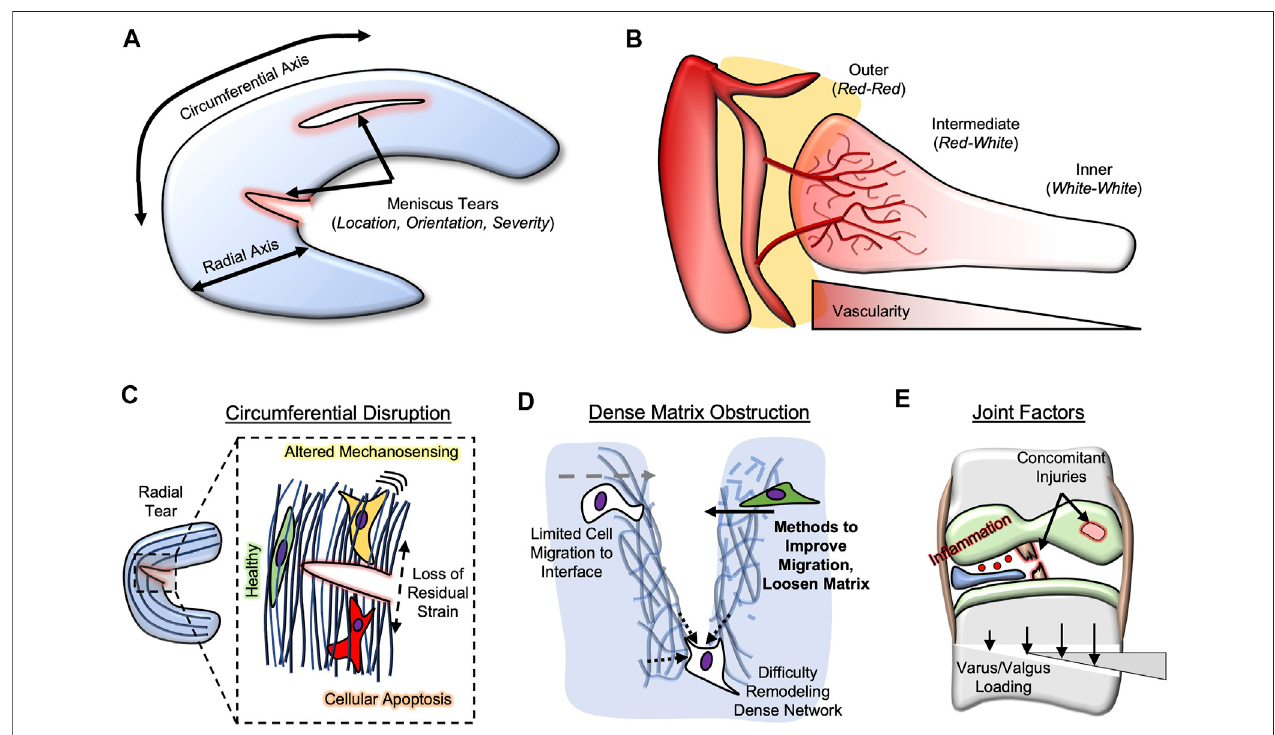
FIGURE 1 | Meniscus Repair Impediments. (A) Meniscus tears are often classi fi ed based on location, orientation, and severity. Location is usually classi fi ed by radial axis (inner, intermediate, outer) and circumferential axis (anterior, body, posterior). (B) Meniscus vascularity penetrates only partially into the meniscal body. (C) Circumferential network disruption (radial tears) lead to loss of residual strain, resulting in altered mechano-sensing and potentially cellular apoptosis. (D) Dense extracellularmatrixcanobstructrepairbylimitingcellmigrationandmatrixremodeling.Methods(e.g.,growthfactors)canimprovemigrationandloosenmatrix. (E) Joint factors that in fl uence meniscal repair include concomitant injuries (e.g., ACl, cartilage), in fl ammation, and varus/valgus